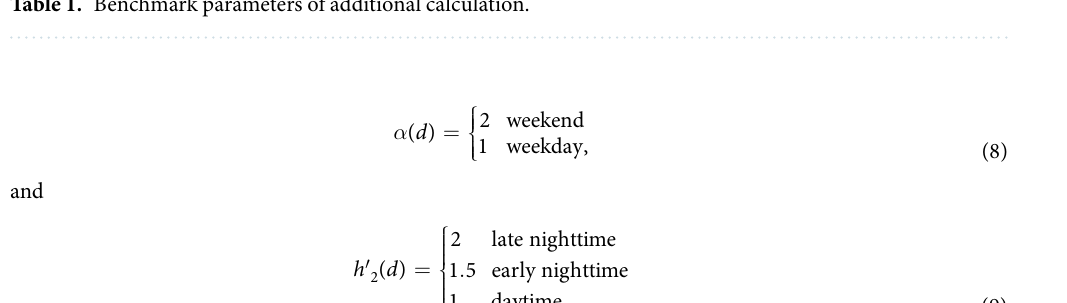
Table 1. Benchmark parameters of additional